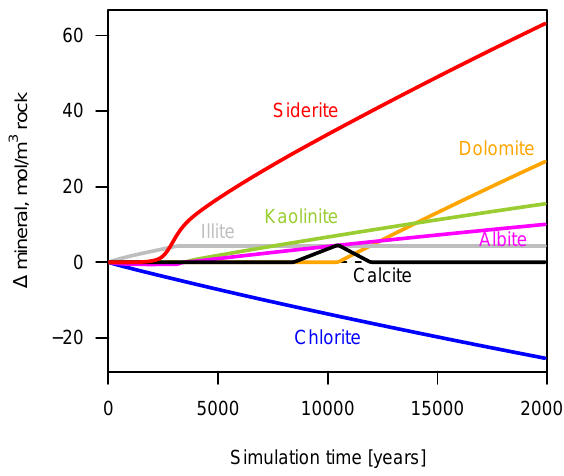
Figure 1. The reference geochemical model, scaled for initial porosity ϕ = 0 . 5 and initial water saturation S w = 0 . 5. Siderite (red) and dolomite (orange) are the main precipitating carbonate phases contributing to mineral trapping; calcite (black) is predicted to ap- pear only transiently. Kaolinite (green), illite (grey) and albite (ma- genta) also precipitates. The newly formed phases are compensated by dissolution of anhydrite cement (not shown) and of chlorite (blue). In terms of porosity changes these reactions can be safely considered negligible in the considered time